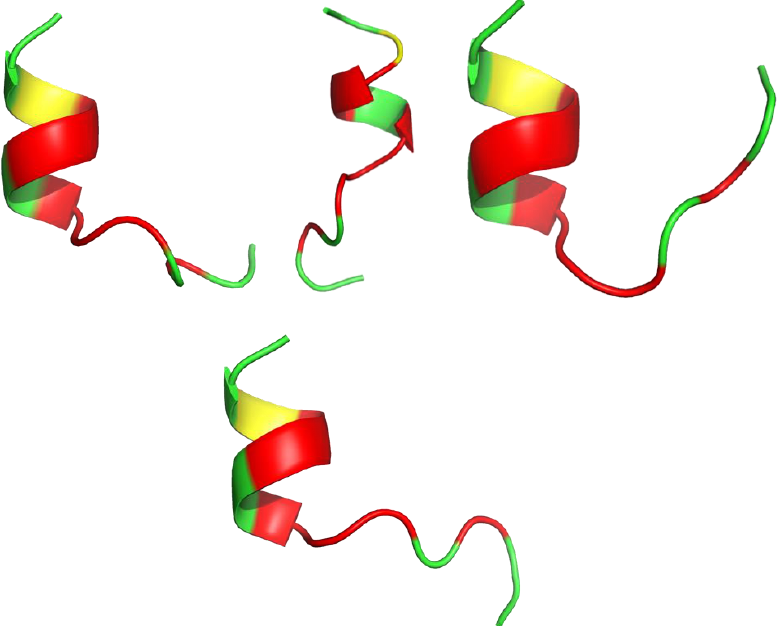
Figure 3. Four models of the antibacterial synthetic peptide pC-CoaTxII structure calculated with I-Tasser. Amino acids are colored in red (hydrophobic), green (positively charged) and yellow (cysteine).